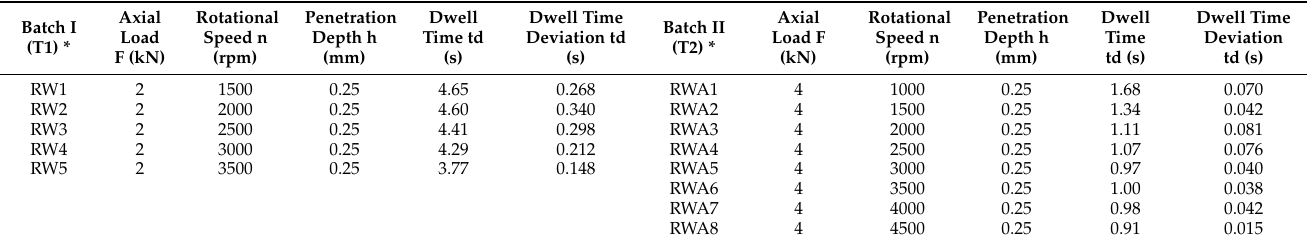
Figure 1. Details of friction stir spot welding (FSSW) tool geometries in (mm). Table 3. Friction stir spot welding (FSSW)